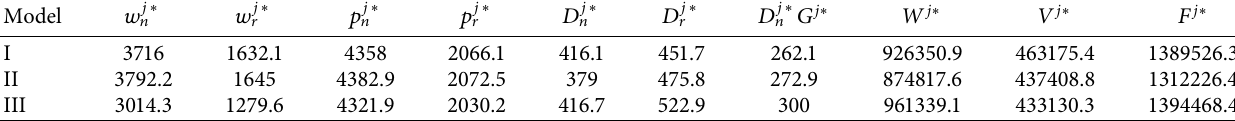
Table 5: Equilibrium results of the three proposed models.